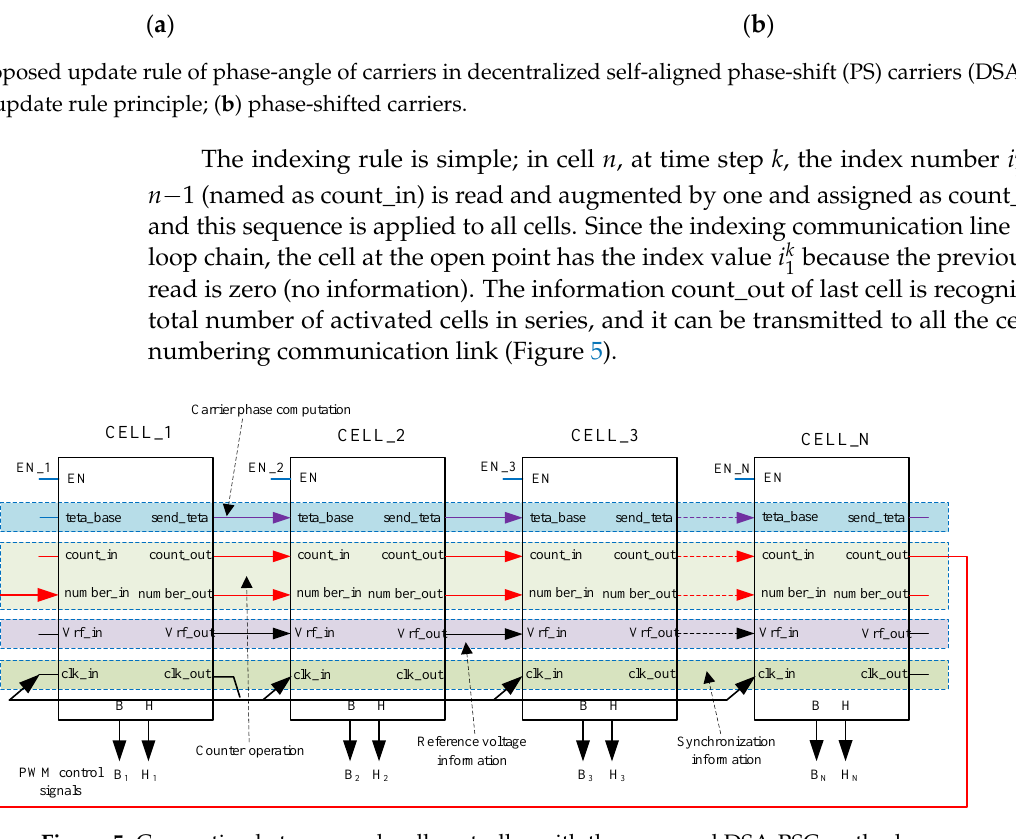
Figure 5. Connection between each cell controller with the proposed DSA-PSC method.